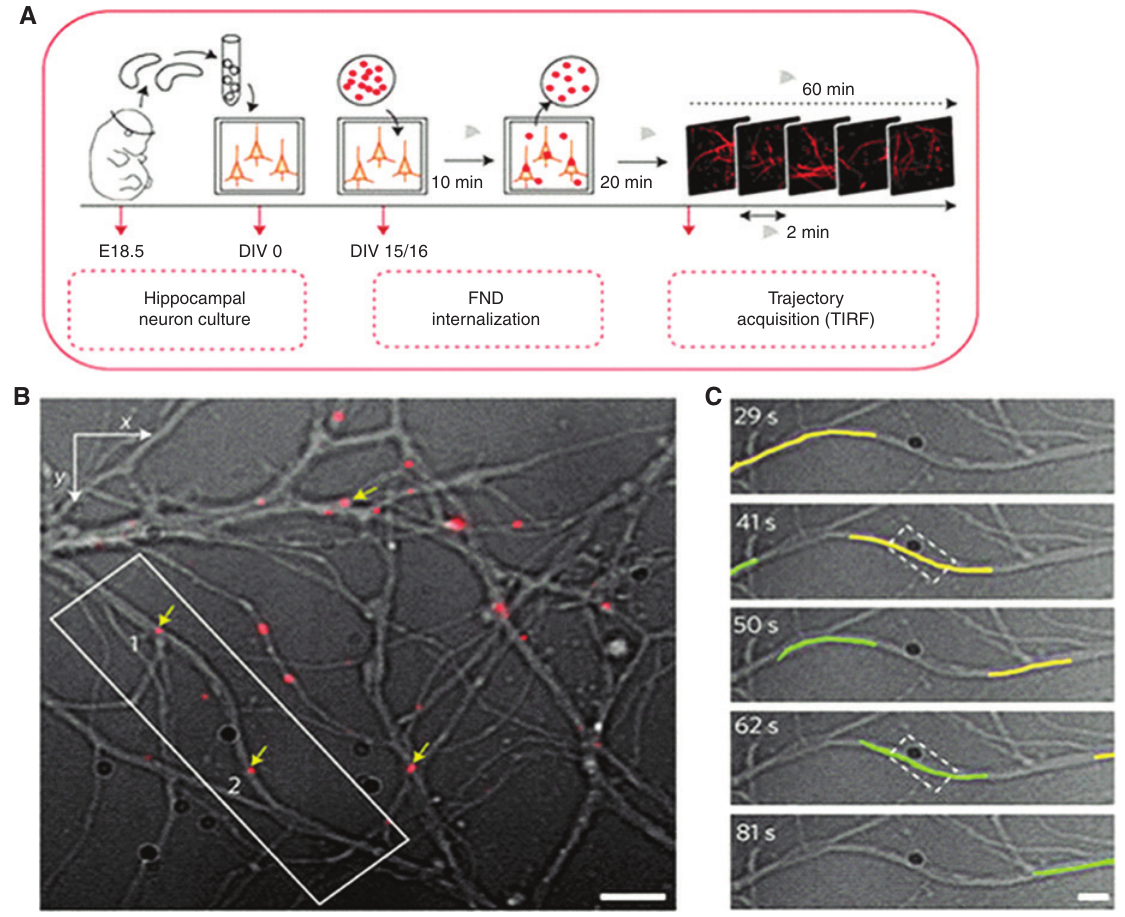
Figure 8: Intracellular tracking of fluorescent nanodiamonds in neuron. (A) An experimental illustration from hippocampal neuron culturing and fluorescent nanodiamonds internalization to imaging. (B) Optical image of the neuronal branches merged with the fluorescence channel showing four FNDs moving within dendrites (yellow arrows). During the 2-min video, two FND-containing endosomes, labelled 1 and 2, were observed moving towards the cell soma in the same branch (scale bar, 5 μ m). (C) Optical image of the positions of these two FNDs (1 in yellow; 2 in green), determined by particle tracking, with a persistence of 10 s, at different times. Adapted from